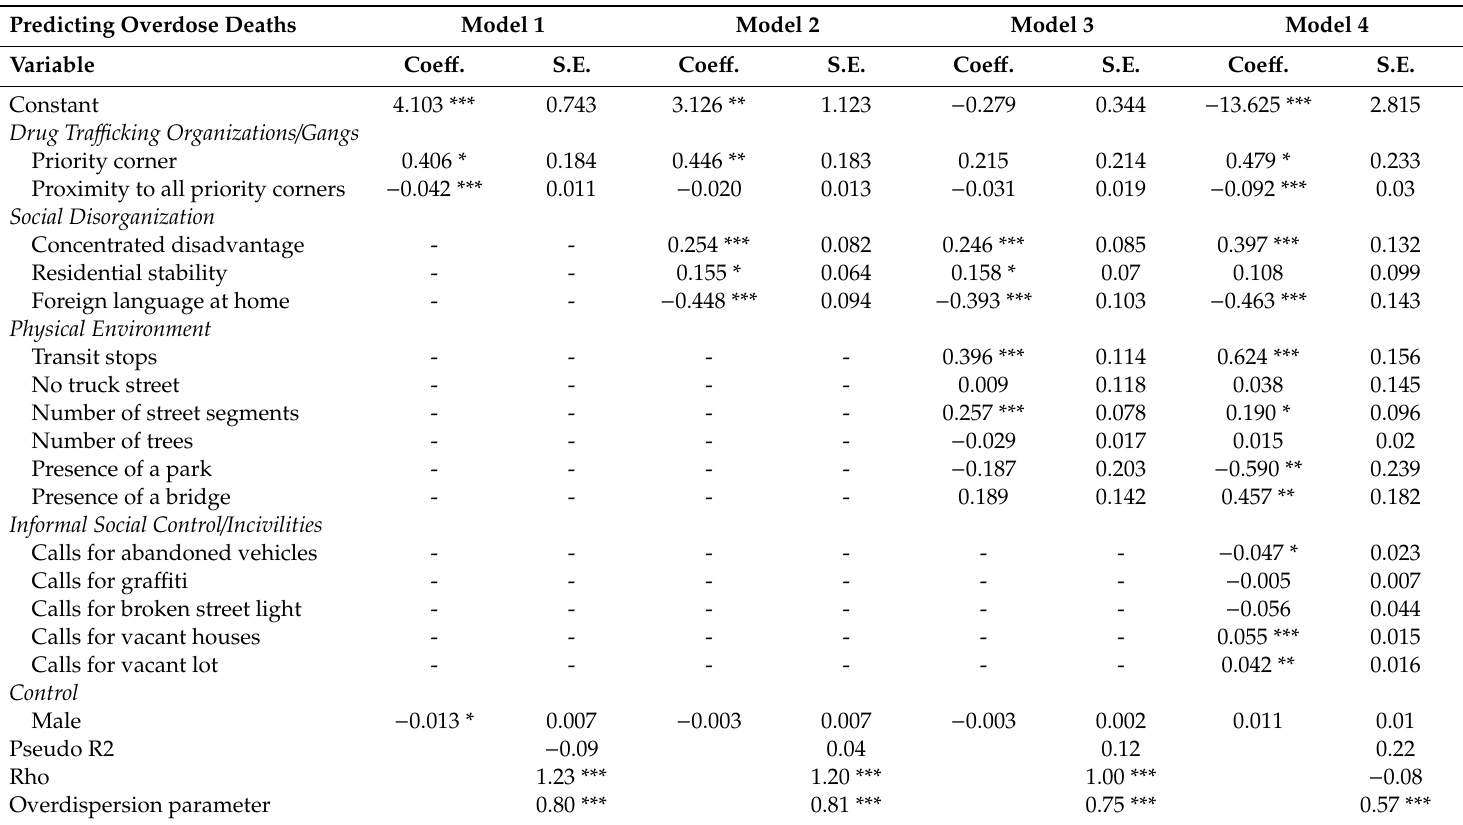
Table 5. GCE Model